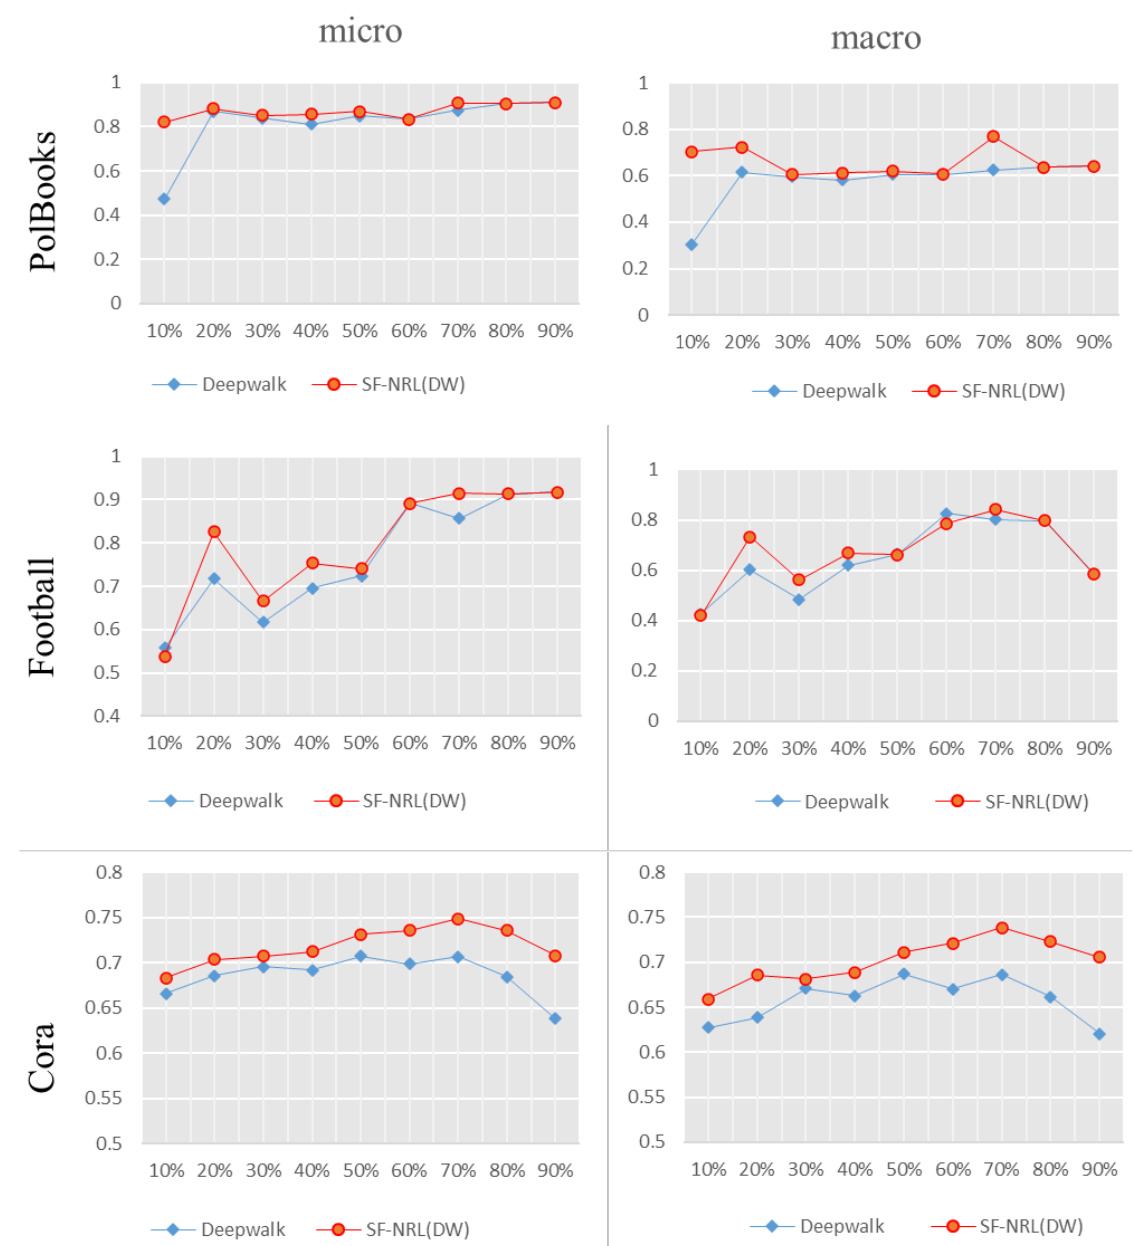
Figure 6. Comparison of F 1 value of the multi-label classification experiment results. The red polyline is the F 1 value of SF-NRL(DW) and the blue one is that of DeepWalk.